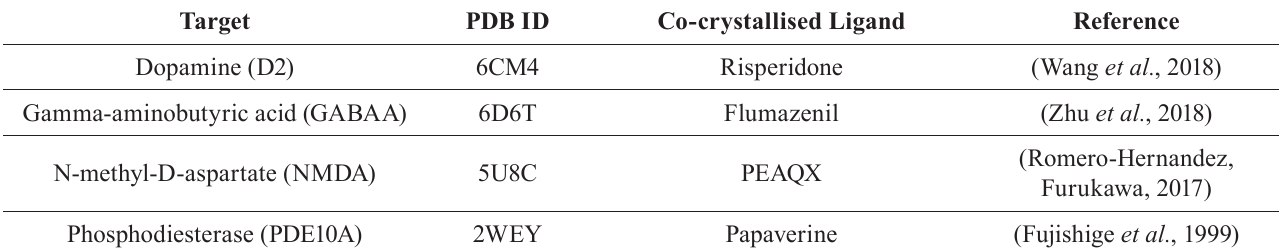
TABLE II - Macromolecular drug targets with their respective PDB ID and co-crystalized